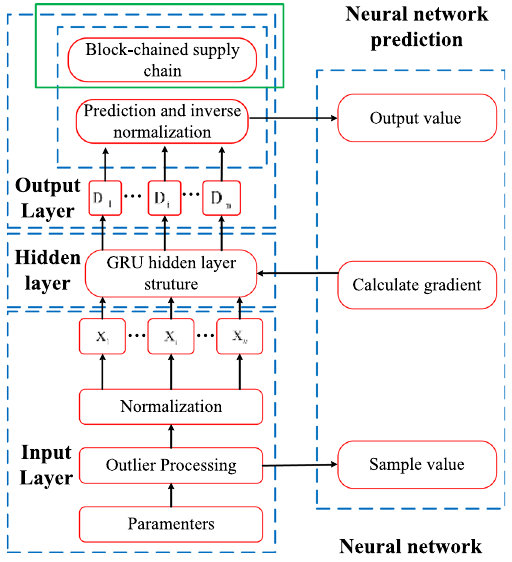
Fig. 7 Prediction flow based on GRU neural